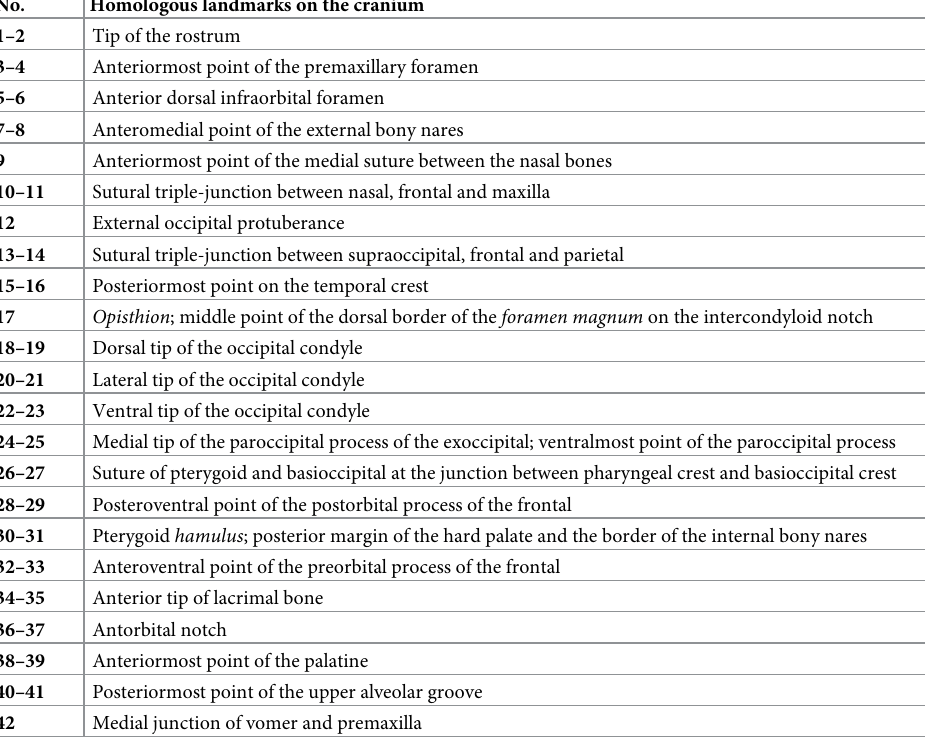
Table 1. Description of the 42 homologous landmarks used in the geometric morphometric analysis of 157 mono- dontid skulls.